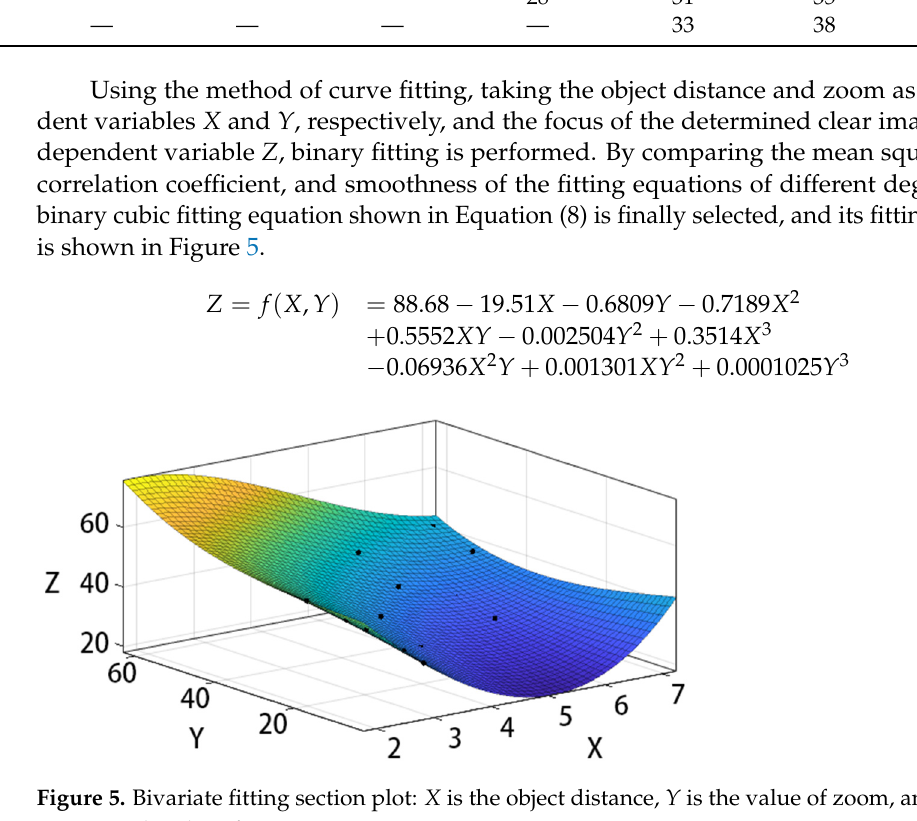
Table 2. The best focus under each object distance and zoom.